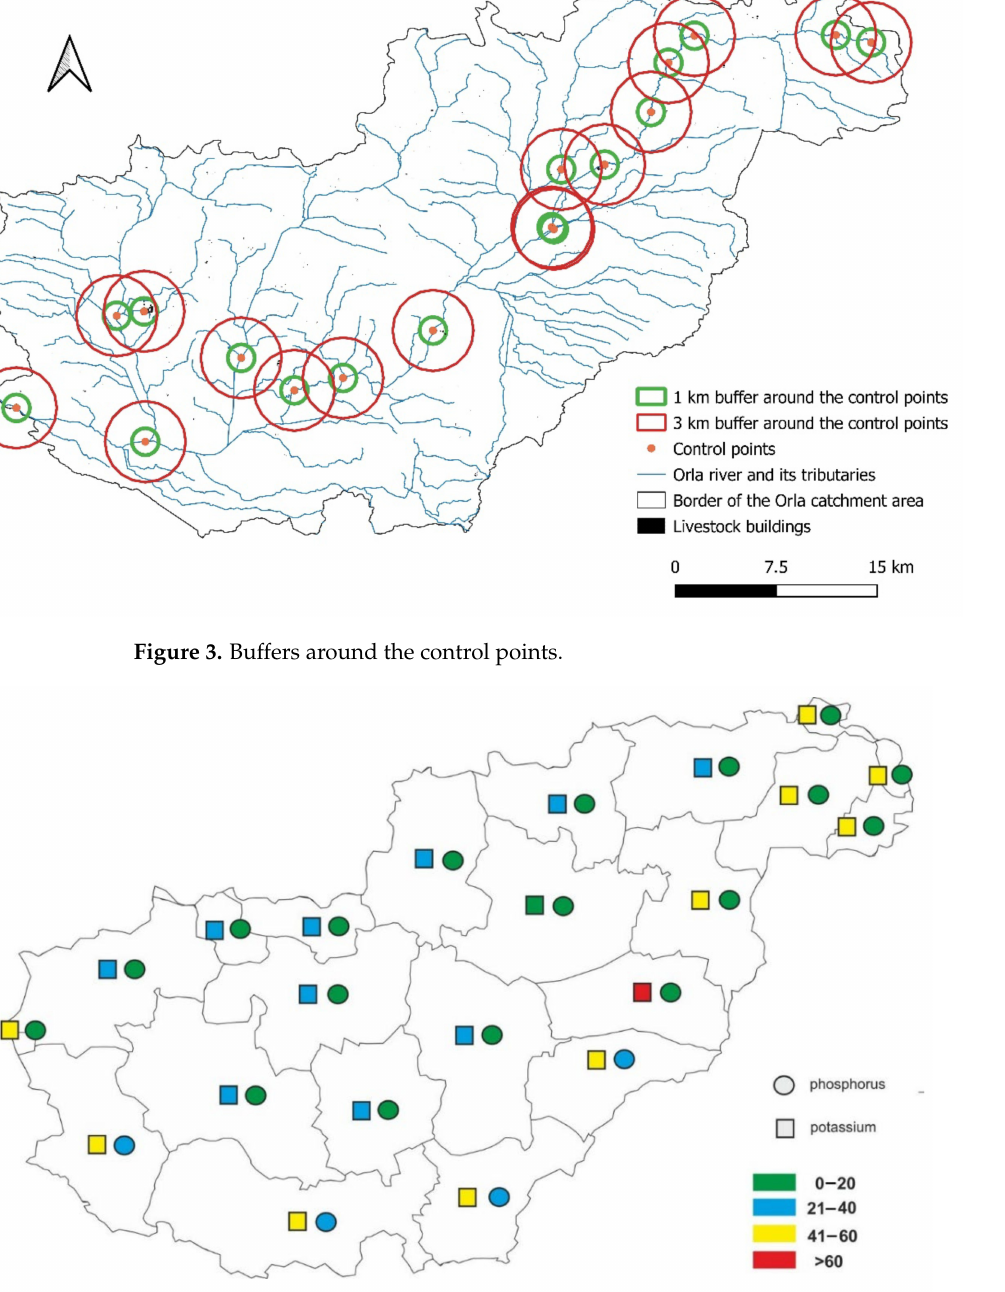
Figure 4. Share of soils with low and very low contents of P 2 O 5 and K 2 O in nitrate vulnerable zone of the Orla River catchment